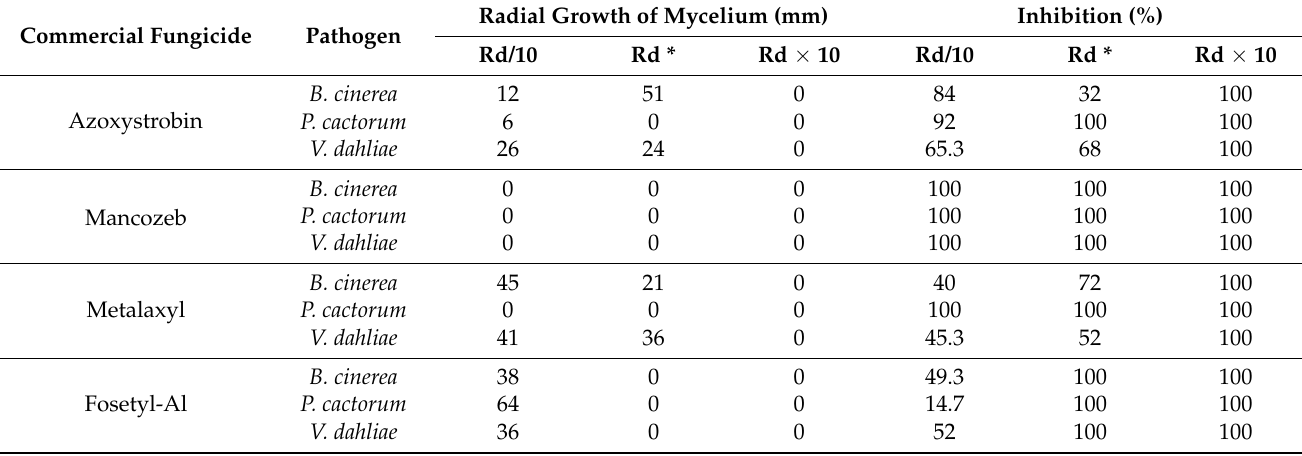
Table 4. Radial growth of mycelium of B. cinerea , P. cactorum , and V. dahliae in in vitro assays performed on a PDA medium amended with different concentrations (the recommended dose, 1/10th of the recommended dose, and 10 times the recommended dose) of four commercial synthetic